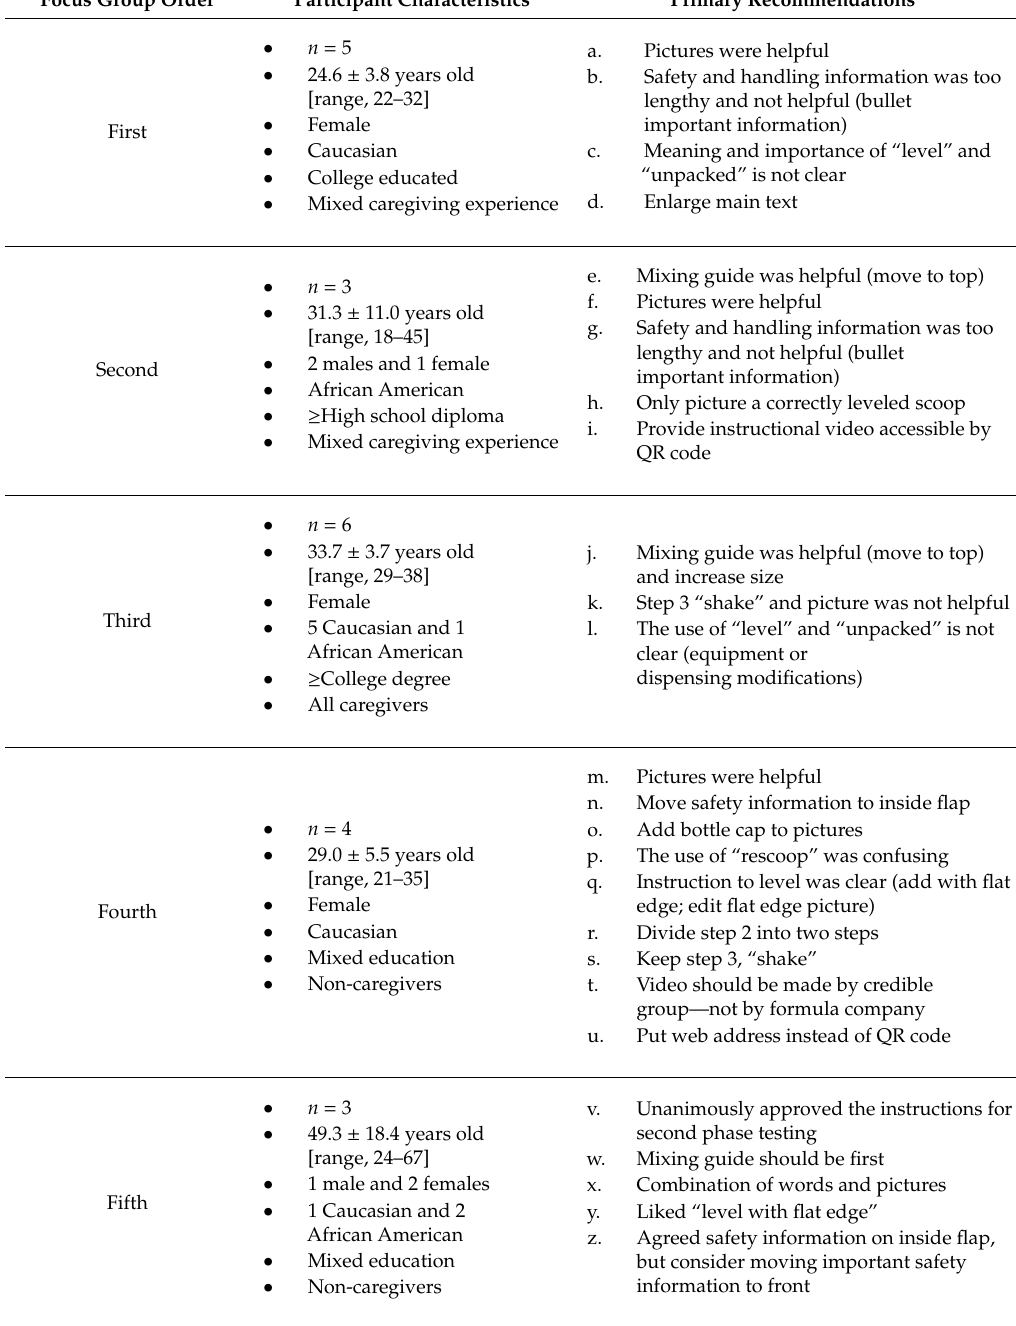
Table 2. Focus Group